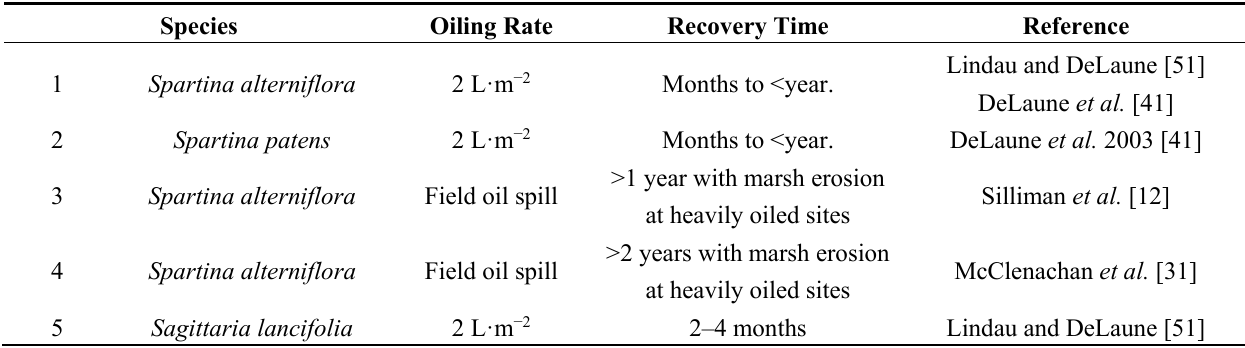
Table 3. Reported field studies of vegetation response and recovery following oiling for selected Louisiana coastal marsh